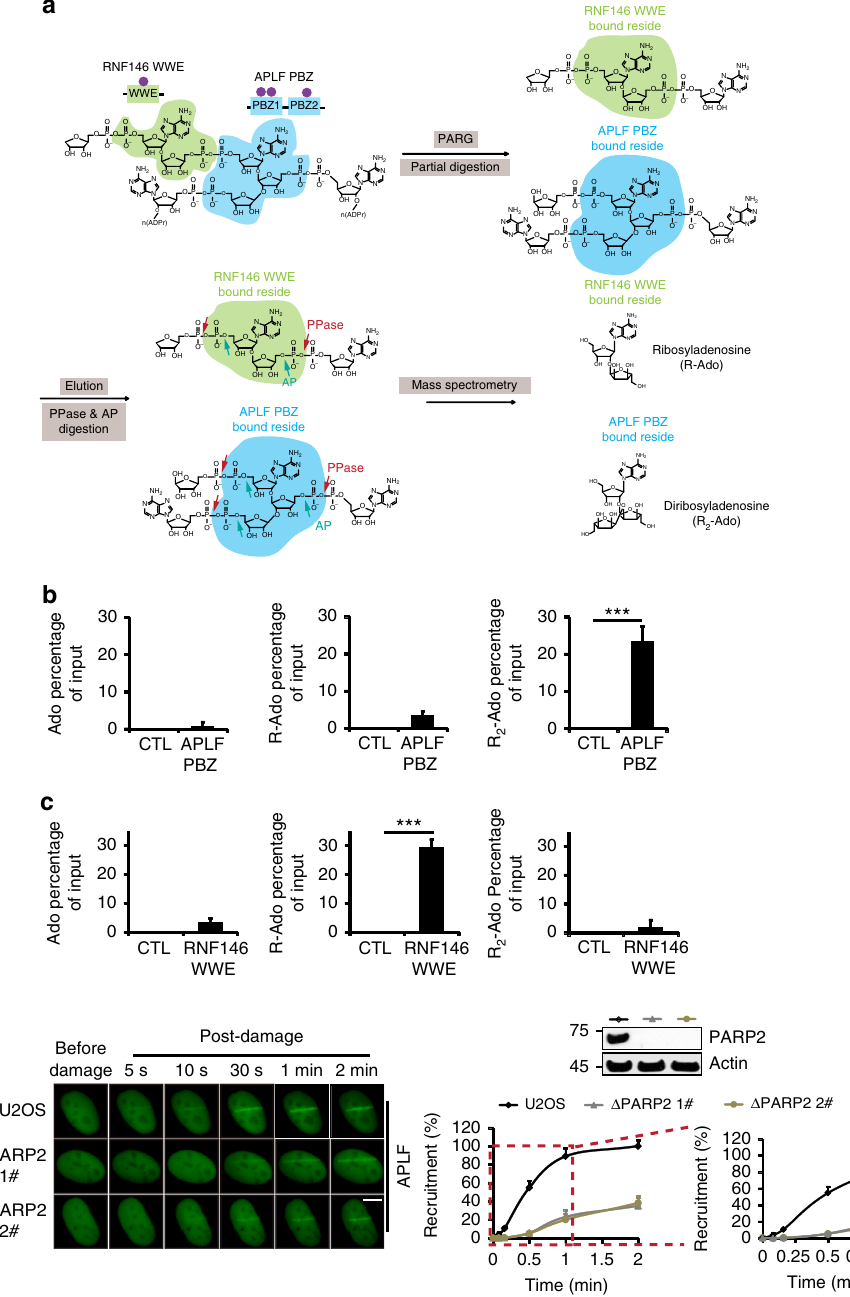
Fig. 5 APLF recognizes the branched PAR. a Diagrammatic representation of the sample preparation. PAR was incubated with APLF PBZ or the WWE domain of RNF146, and then partially digested by PARG. The protein-associated residues were further treated with PPase and AP, and then subjected to LC – MS/MS. APLF PBZ ( b ) or the WWE domain of RNF146 ( c ) bound residues were examined. d The recruitment of APLF to DNA lesions is dependent on PARP2. GFP-APLF was expressed in U2OS or PARP2-null cells. The recruitment kinetics of APLF was examined following DNA damage at various time intervals. Scale bar represents 5 μ m. Data are represented as mean ± s.d. as indicated from three independent experiments. Signi fi cance of differences